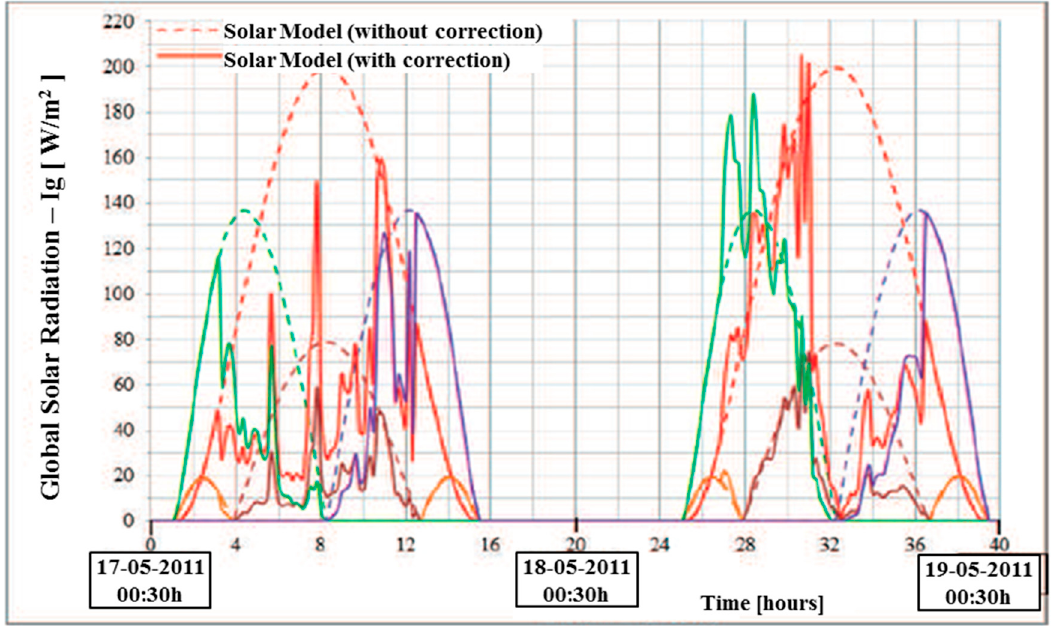
Figure 14. Absorbed radiation, by a white surface ( α s = 0.25), estimated by the solar model for T l = 4.5 and corrected for the observed cloudiness, between 17th and 18th May.